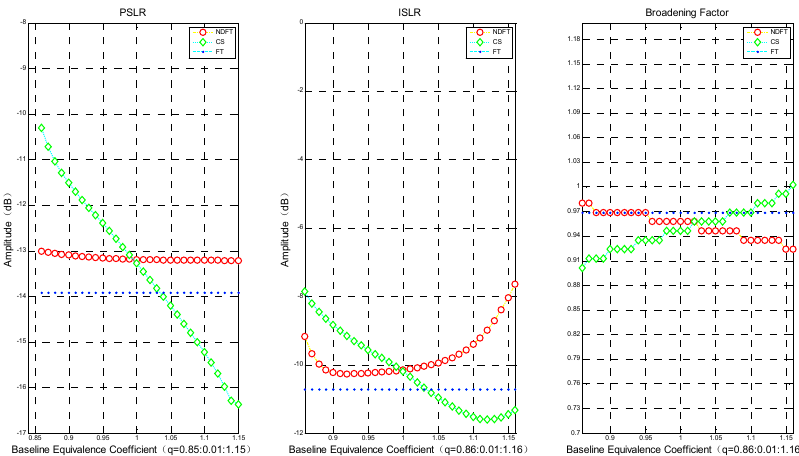
Figure 6. The imaging performance along the deviation direction with q = 0.86 ∼ 1.16: PSLR, ISLR, broadening coefficient.